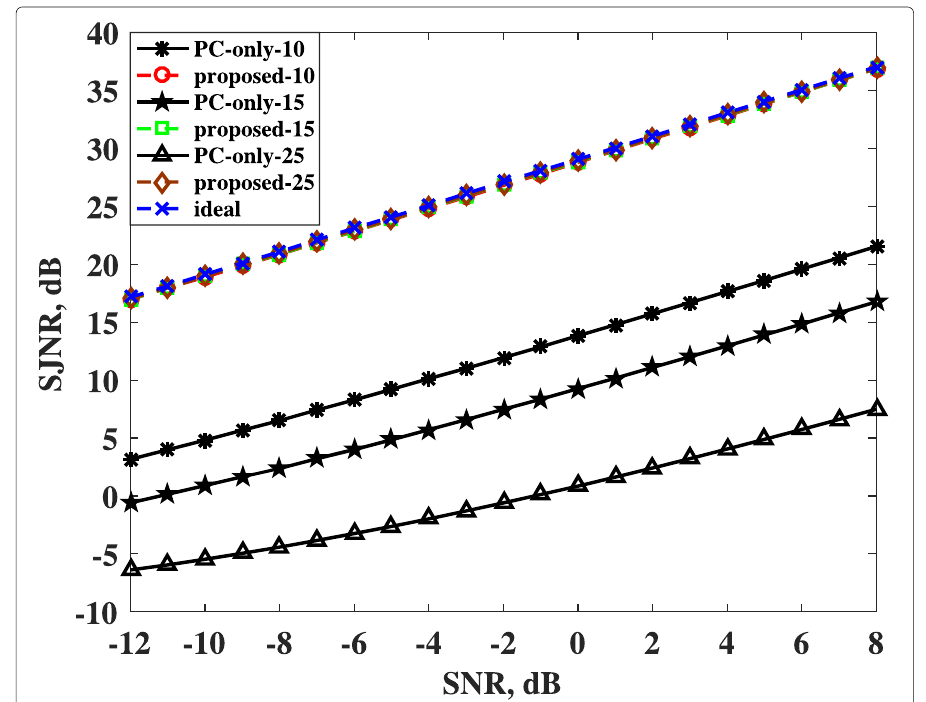
Fig. 7 The output SJNR under different input SNR in the CNJ